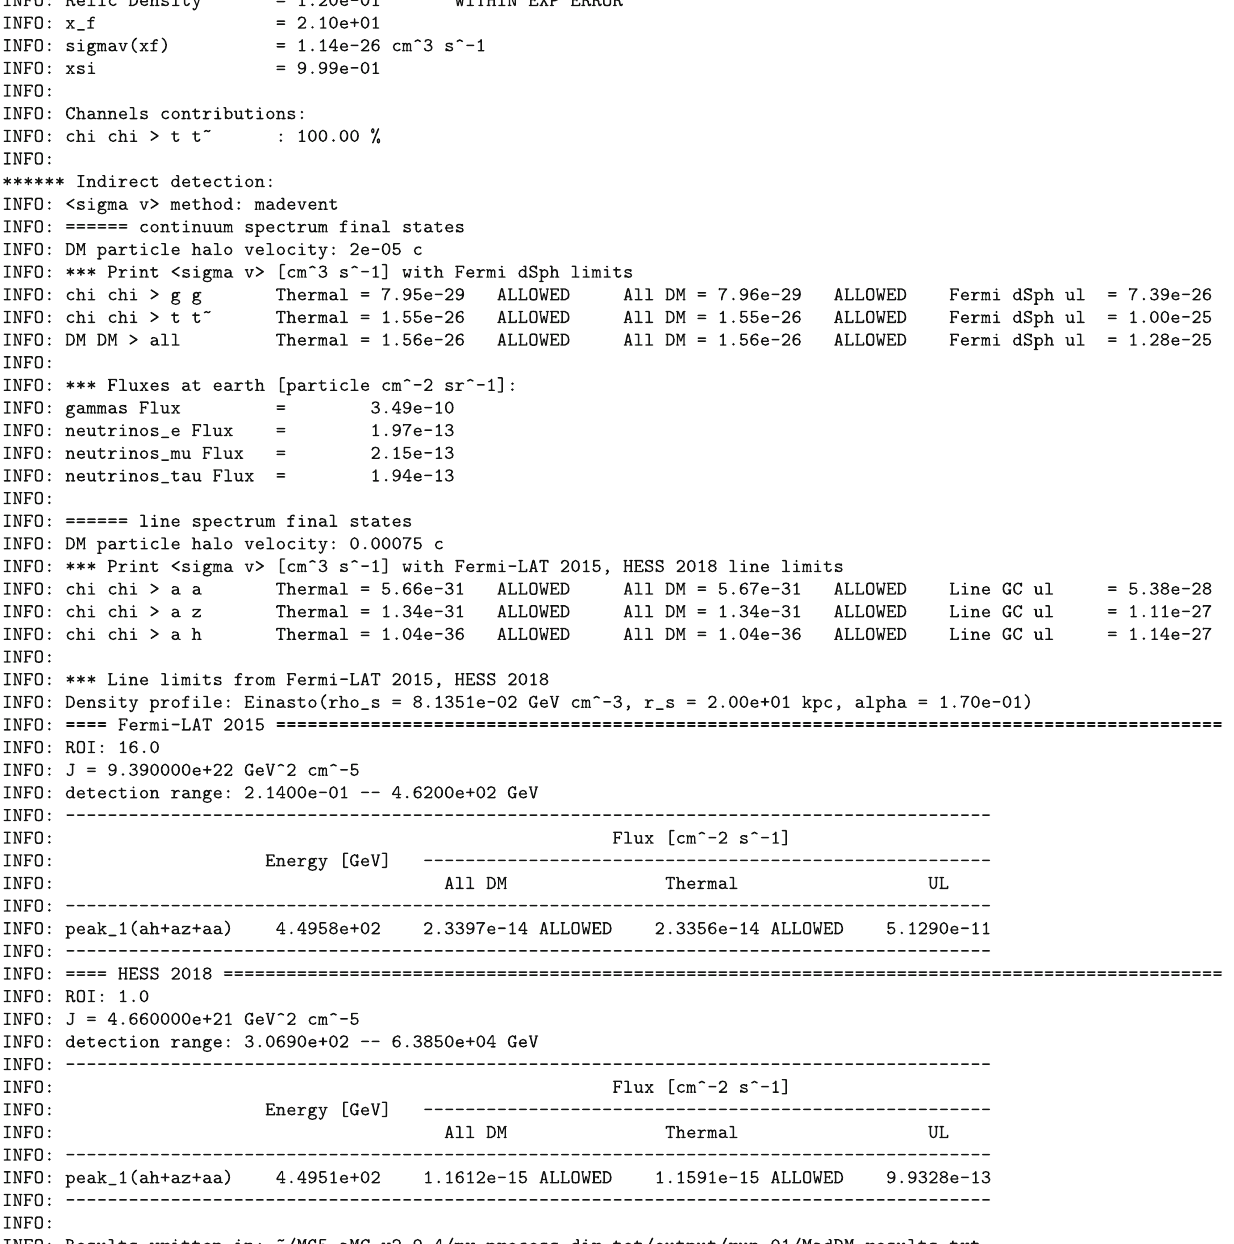
Fig. 8 Exampleofoutputprovidedby MadDM whenrunningrelicdensityandallindirectdetectioncomputations.Thenumbersquotedcorrespond to the benchmark model point taken as an